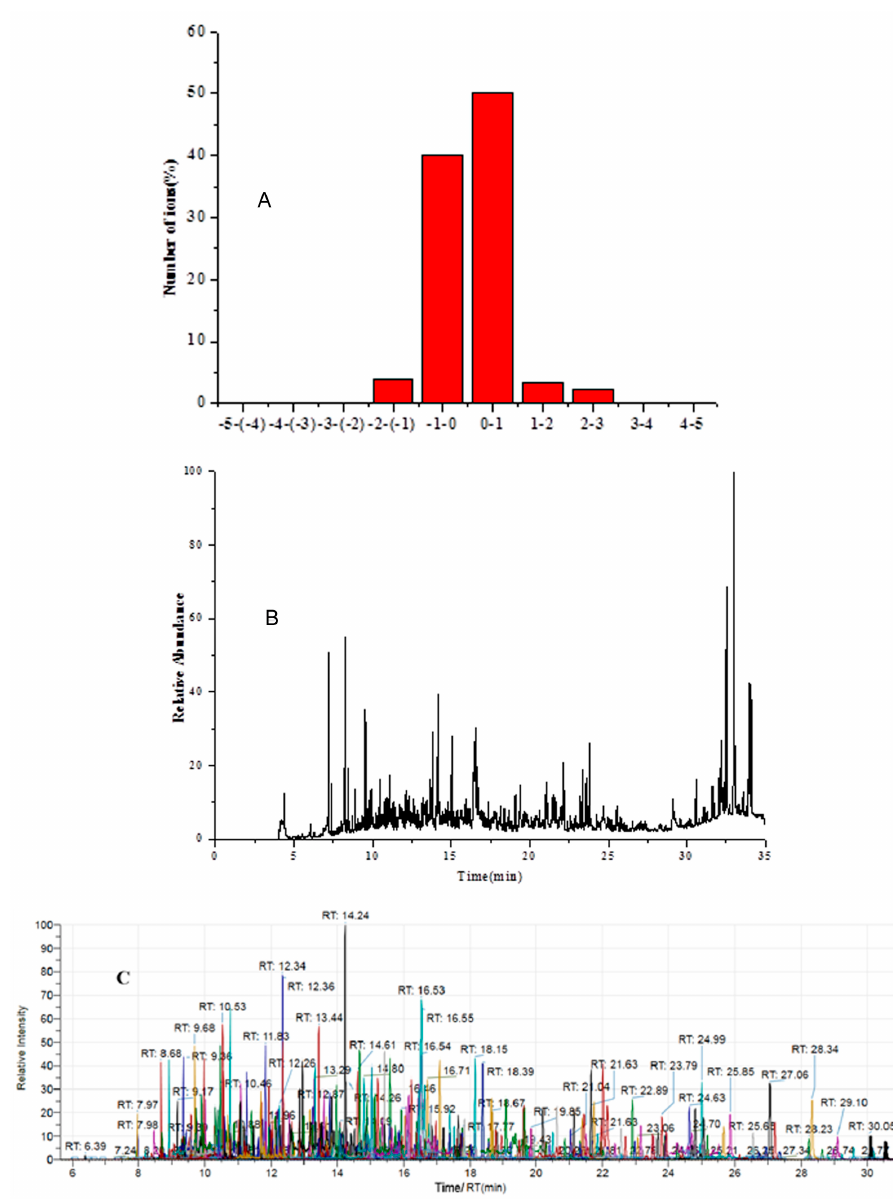
Figure 4. Mass error ( A ), total ion chromatogram ( B ) and multiple extracted ion chromatograms ( C ) of 350 of pesticides spiked in the orange juice matrix at 100 μ g/kg.